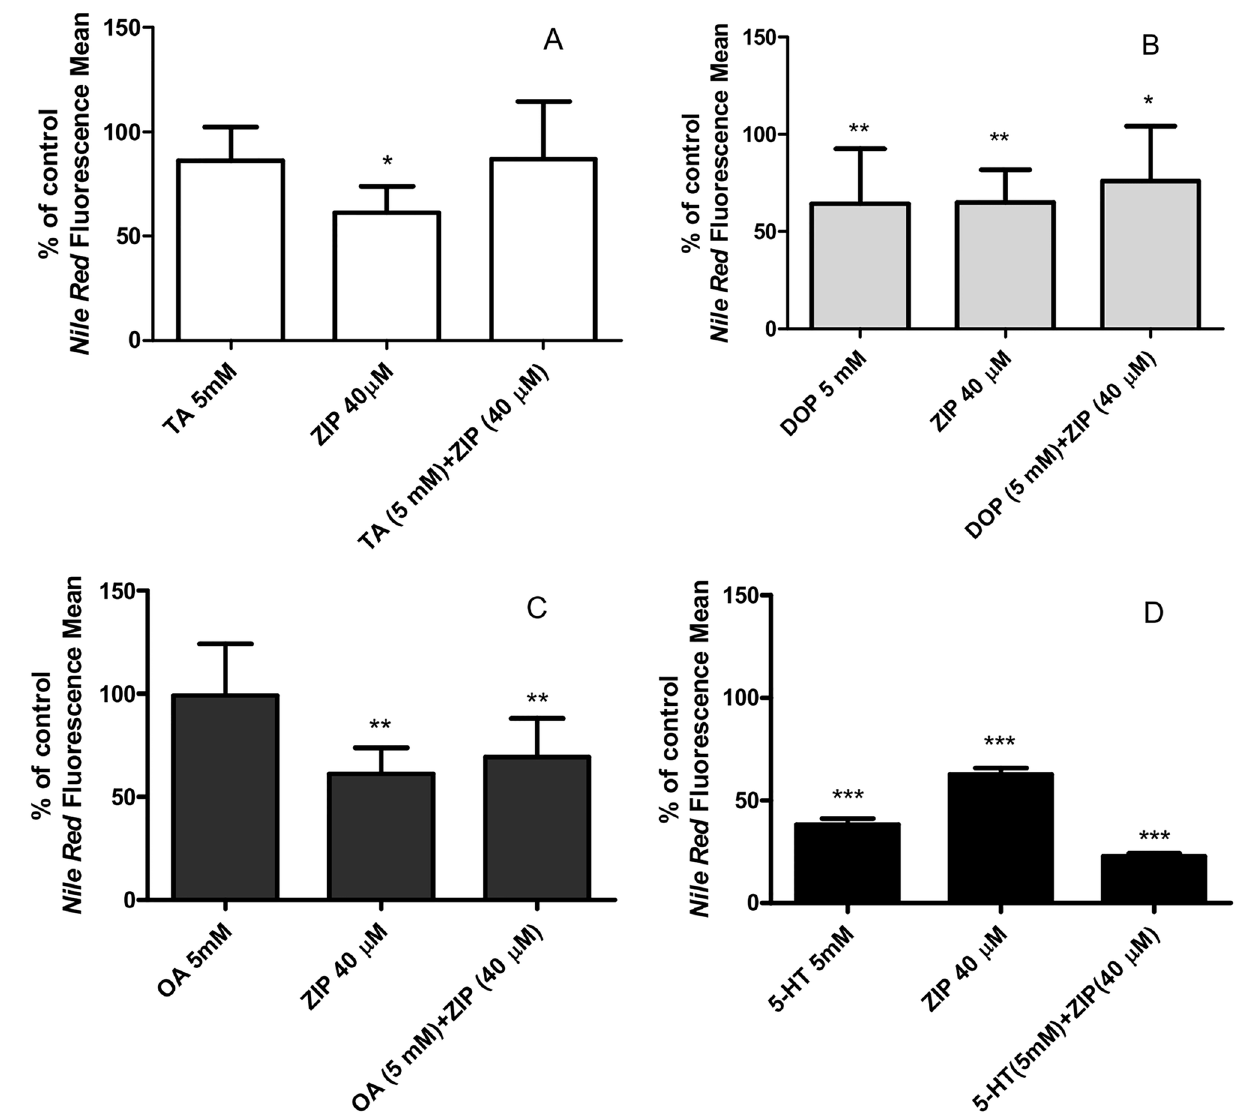
Figure 10. Effects on lipid stores after exogenous exposition to the monoamines and Ziprasidone in wild-type worms (N2). The nematodes were exposed to the monoamines (A) tyramine (TA, 5 mM), (B) dopamine (DA, 5 mM), (C) octopamine (AO, 5 mM) and (D) serotonin (5-HT, 5mM) isolated or concomitant to the Ziprasidone (40 µM). The fat amount was evaluated using Nile Red labeling follow density quantification in the first intestinal pair cells. The results were expressed in percentage of respective control: HCl 0.1N (compared to the monoamines), DMSO (0.16% in Acetic acid (1:10 000), compared to the Ziprasidone group) and HCl + DMSO (compared to the monoamine + Ziprasidone association). *p<0.05; **p<0.01; ***p<0.001, statistically different compared to the respective control by one way ANOVA with Bonferroni correction for post hoc multiple comparisons (% of control, SD, n=20).